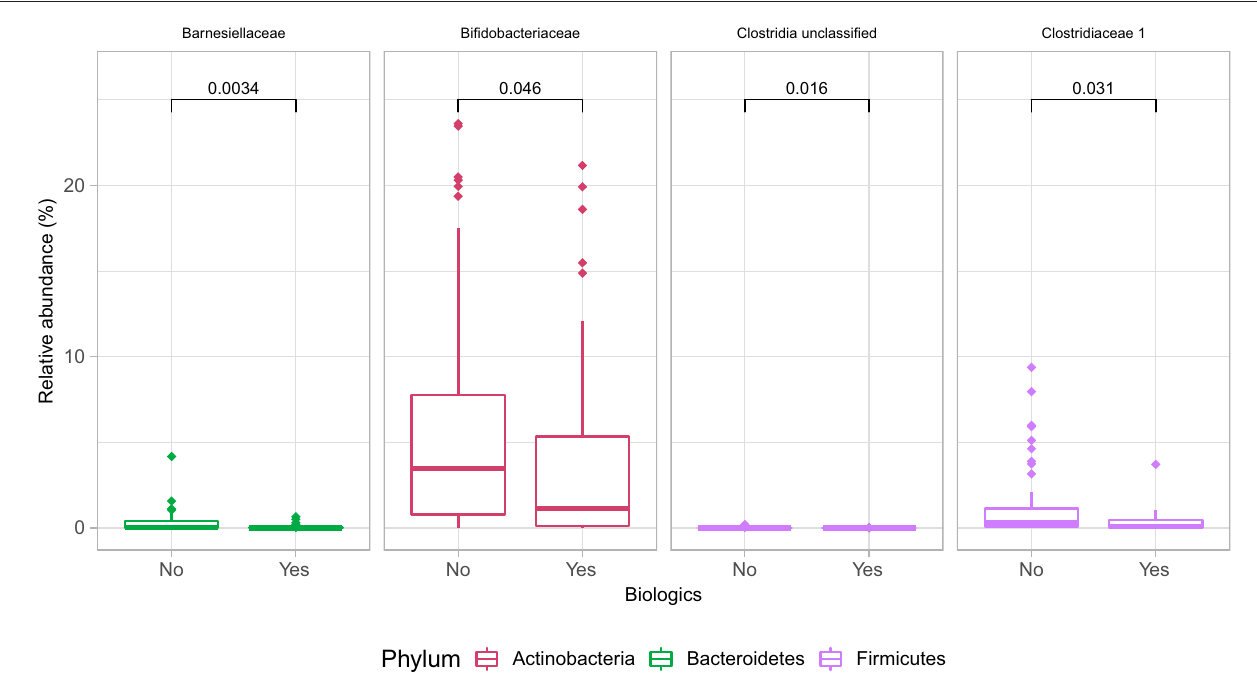
Frontiers in Medicine |